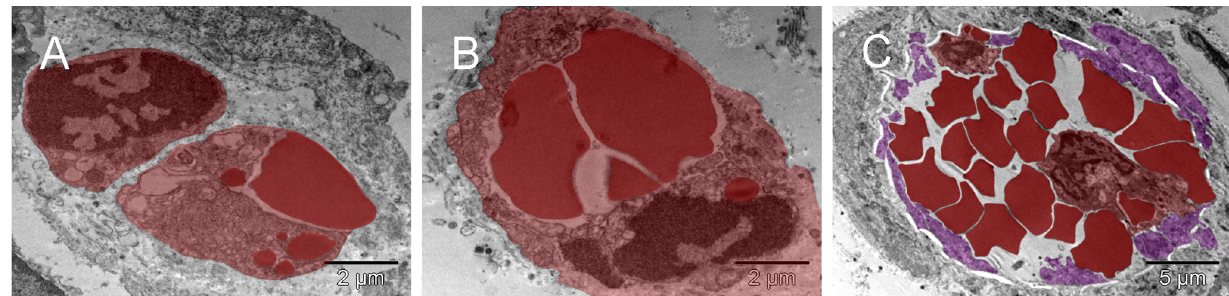
Figure S3. Extramedullar erythropoiesis via nucleo-cytoplasmic conversion. The single cells undergoing structural remodeling in the nucleus and cytoplasm represented at slightly different stages of erythropoiesis [ A & B ]. Conceivably, a few such cells (red), when gathered into a cluster, could fill up a larger space with erythrosomes creating a cobble stone pattern, also called ‘erythropoietic lake’ or myeloplaxes [ C ]. Platelets and megakaryocyte (purple) were recognizable at the periphery of the